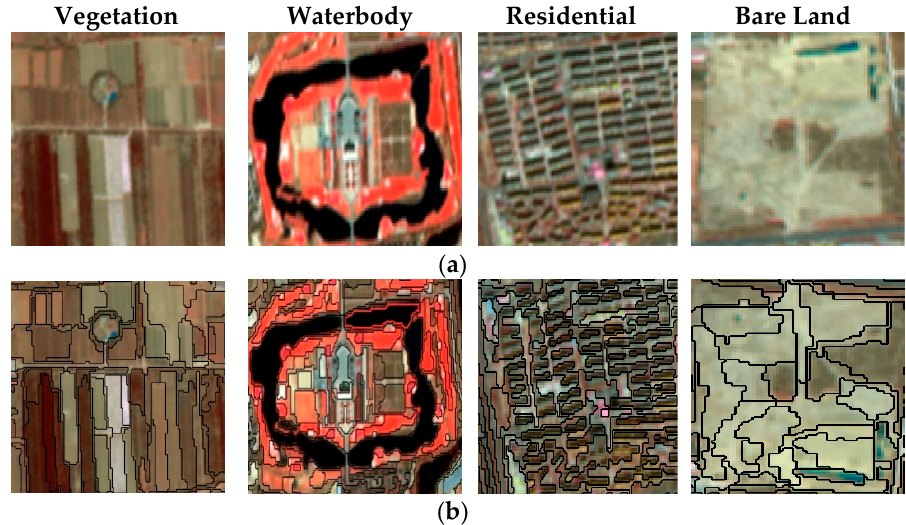
Figure 6. ( a ) Typical land cover types on the GF-1 images. ( b ) Multi-scale segmentation results of the GF-1 images.